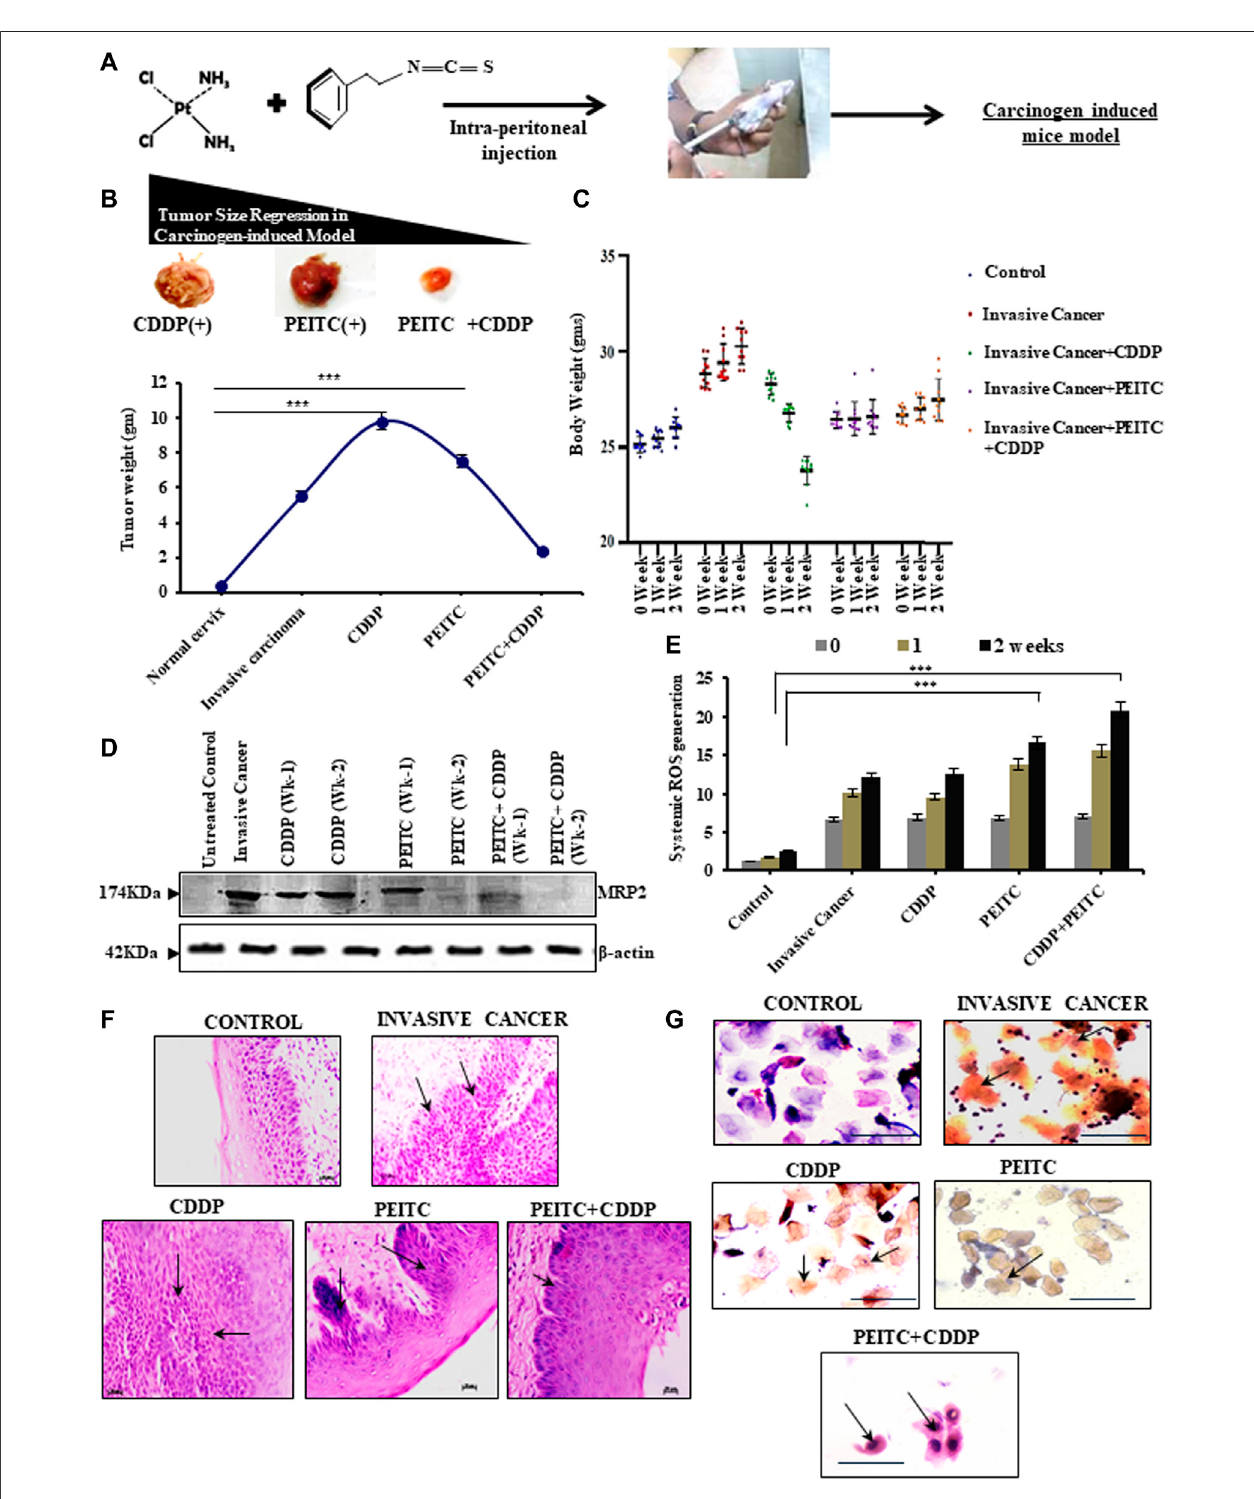
FIGURE 4 | (A) Clear outline of the treatment protocol observed for animal experimentations in a carcinogen-induced cervical cancer model. (B) Pictorial (upper panel)andcorroborativegraphicaldescriptions(lowerpanel)oftumorsizeregressionamonginvasivecancer-bearingmiceaftertreatmentwithCDDPorPEITCorCDDP + PEITC. (C) Trends in body-weight alterations in mice upon interventions with PEITC (5 mg/kg body weight) and CDDP (3 mg/kg body weight) either in combination or solelywithrespecttountreatedhealthycontrolandnon-intervenedinvasivecancer-bearingmice. (D) WesternblotresultsdepictingthemodulatoryeffectofPEITC upon the expression pro fi les of MRP2 proteins in the carcinogen-induced cervical tumor microenvironment in the isolated or combination mode. (E) Graphical